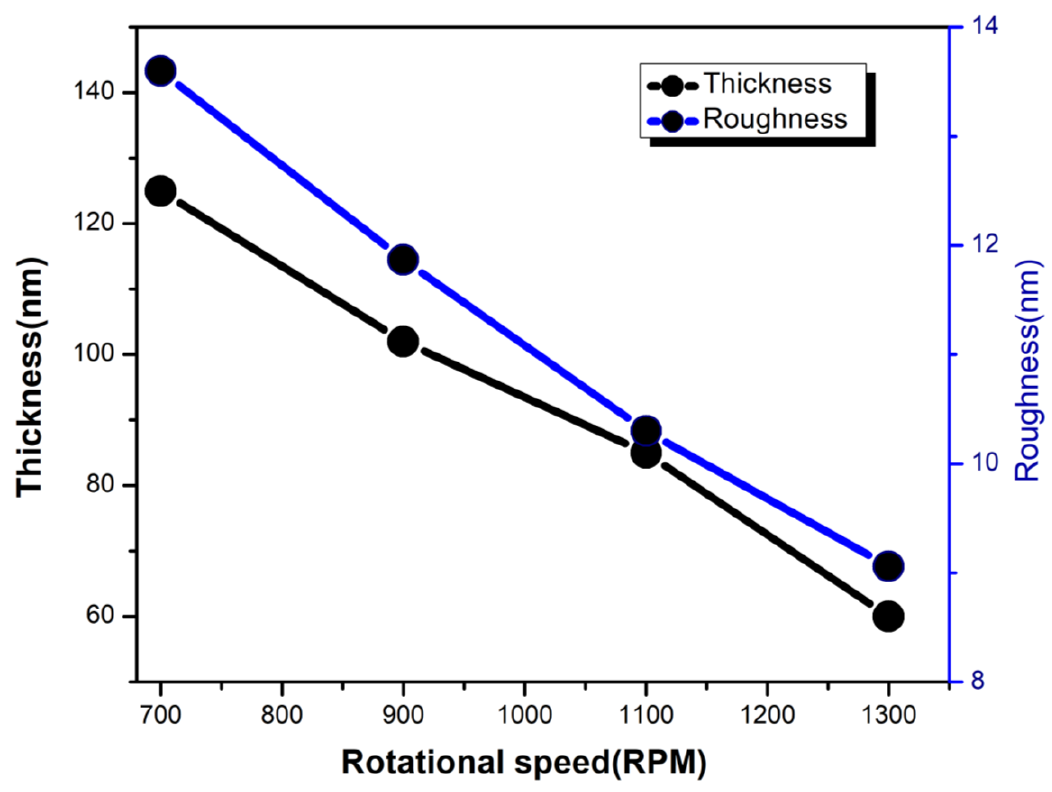
Figure 6. The variation in film thickness and surface roughness of NiO thin films as a function of rotational speed (RS).